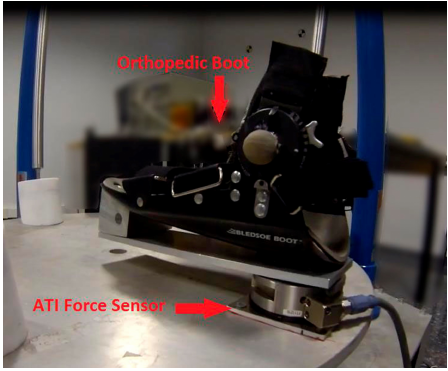
Figure 5. The orthopedic boot and the force sensor attached to the